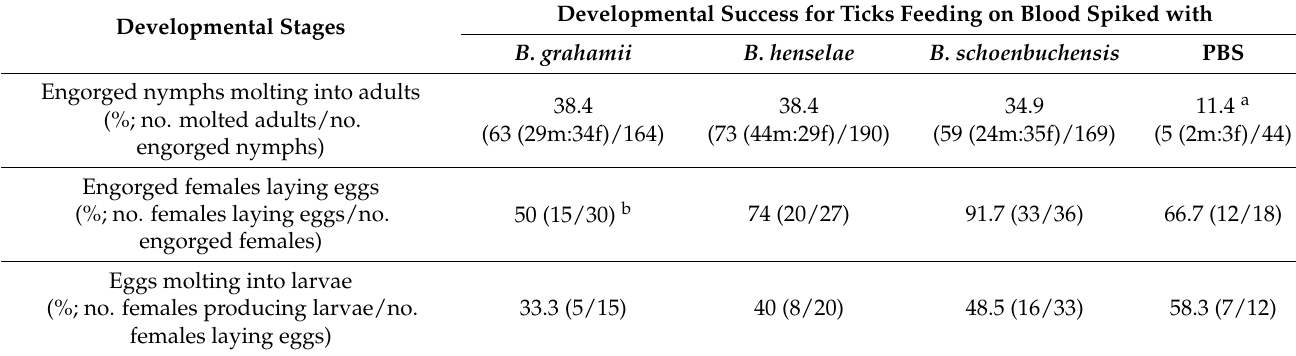
Table 2. Developmental success of ticks feeding on blood spiked with Bartonella spp. and PBS (negative control groups). Developmental Success for Ticks Feeding on Blood Spiked with Developmental Stages B.